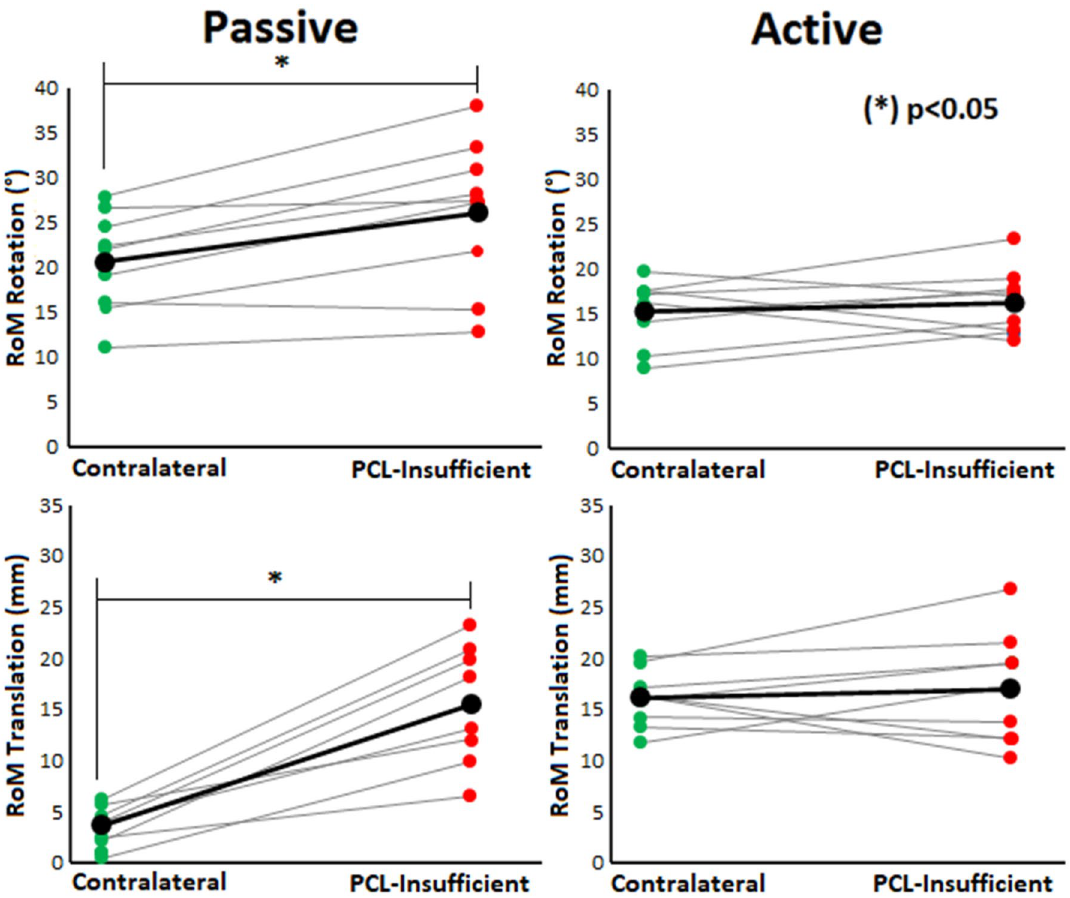
Figure 4. Comparison of passive rotational (at 90° of knee flexion) and passive translational RoM to active rotational and translational RoM during level walking. Significant differences between PCL insufficient and CL knees were found only during passive conditions. Range of Motion (RoM); Posterior cruciate ligament (PCL); Contralateral